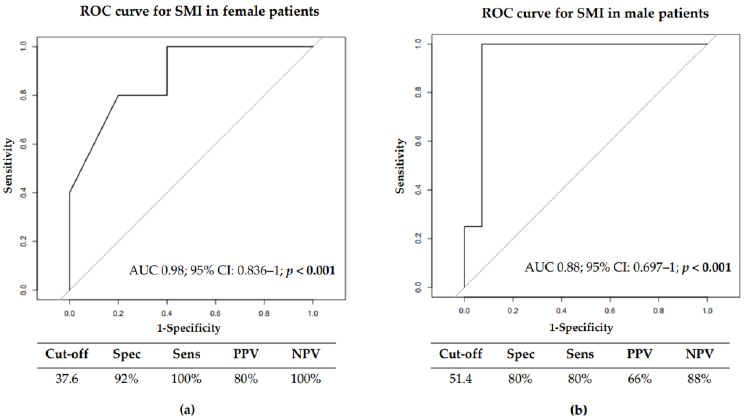
Figure 3. ROC curve for Skeletal Muscle Index in female ( a ) and male ( b ) in 33 non-sarcopenic pa- tients at baseline. patients at